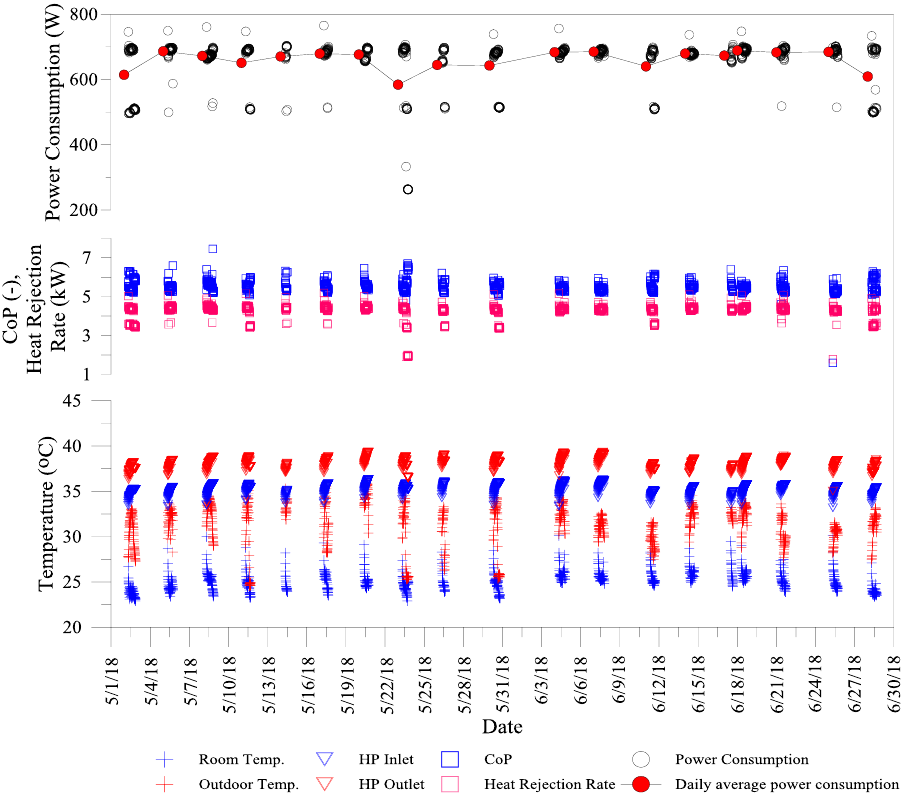
Figure 11. Performance of GSHP 1 (10-min interval data during the operational period).